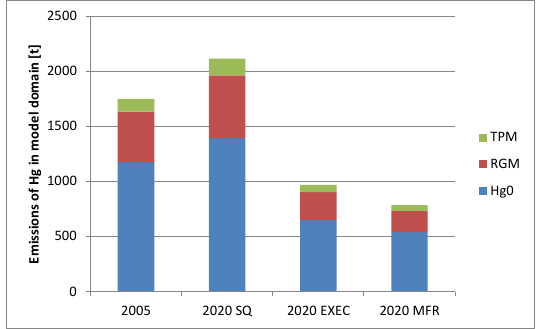
Figure 6. The total annual emission in tons Hg within the model domain for the four different emission scenarios, split up in emission of Hg 0 , reactive Hg (RGM) and particulate Hg